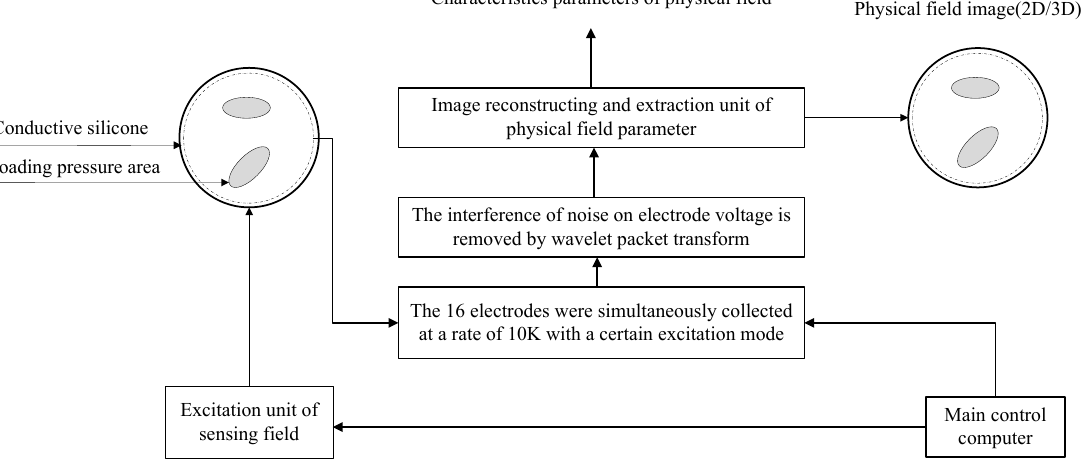
Figure 2. The process of visual inversion of pressure distribution.